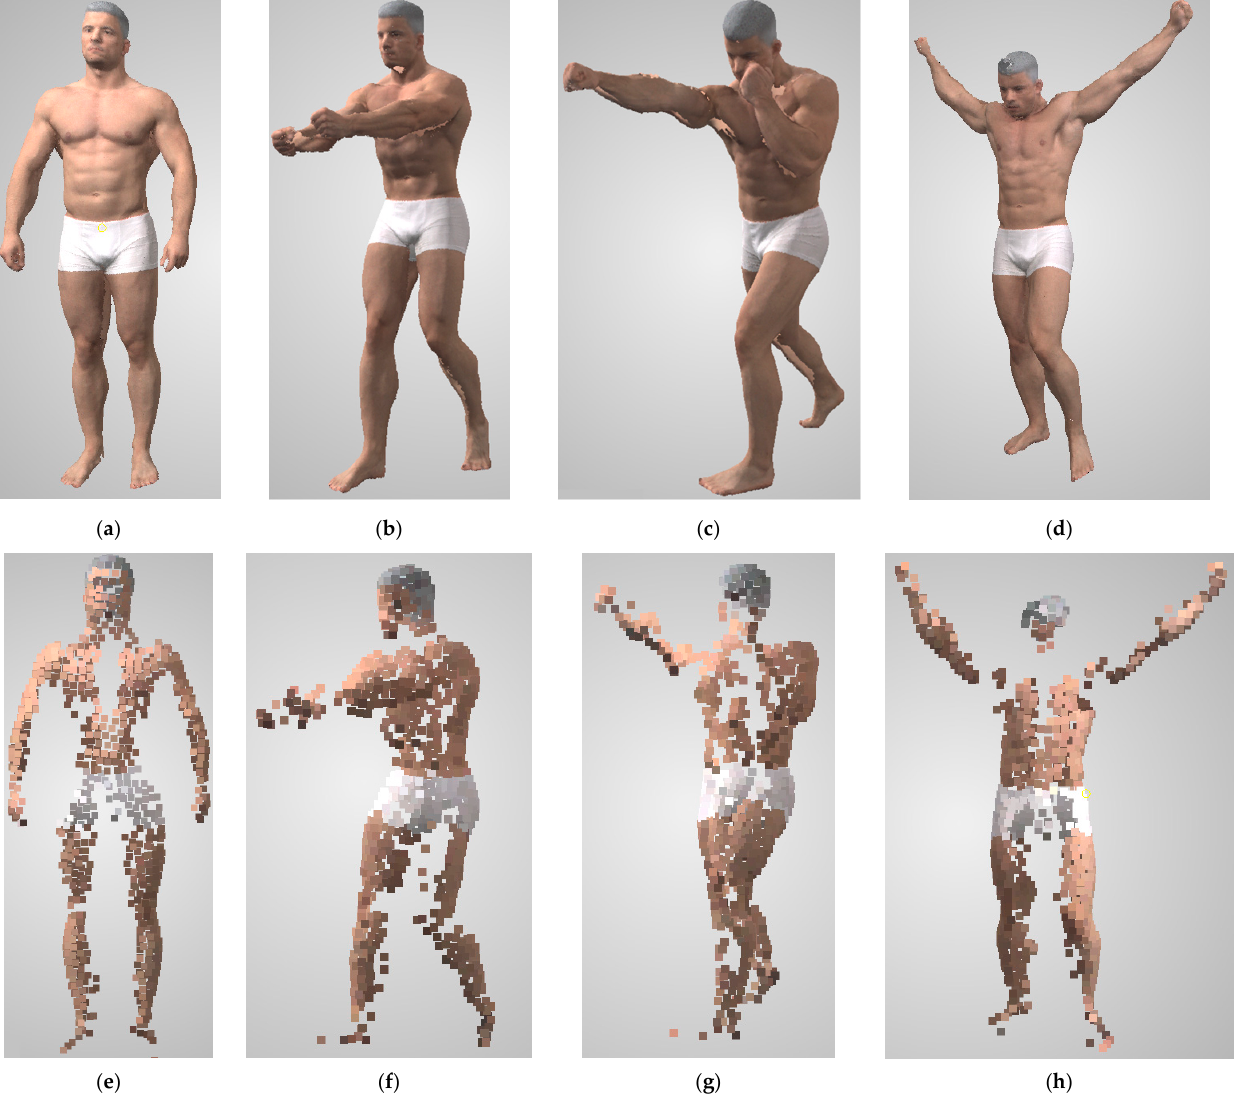
Figure 19. 3D reconstructions of the human in different poses: ( a ) pose 1, ( b ) pose 2, ( c ) pose 3, ( d ) pose 4, with corresponding unoccluded sparse point clouds ( e – h ).